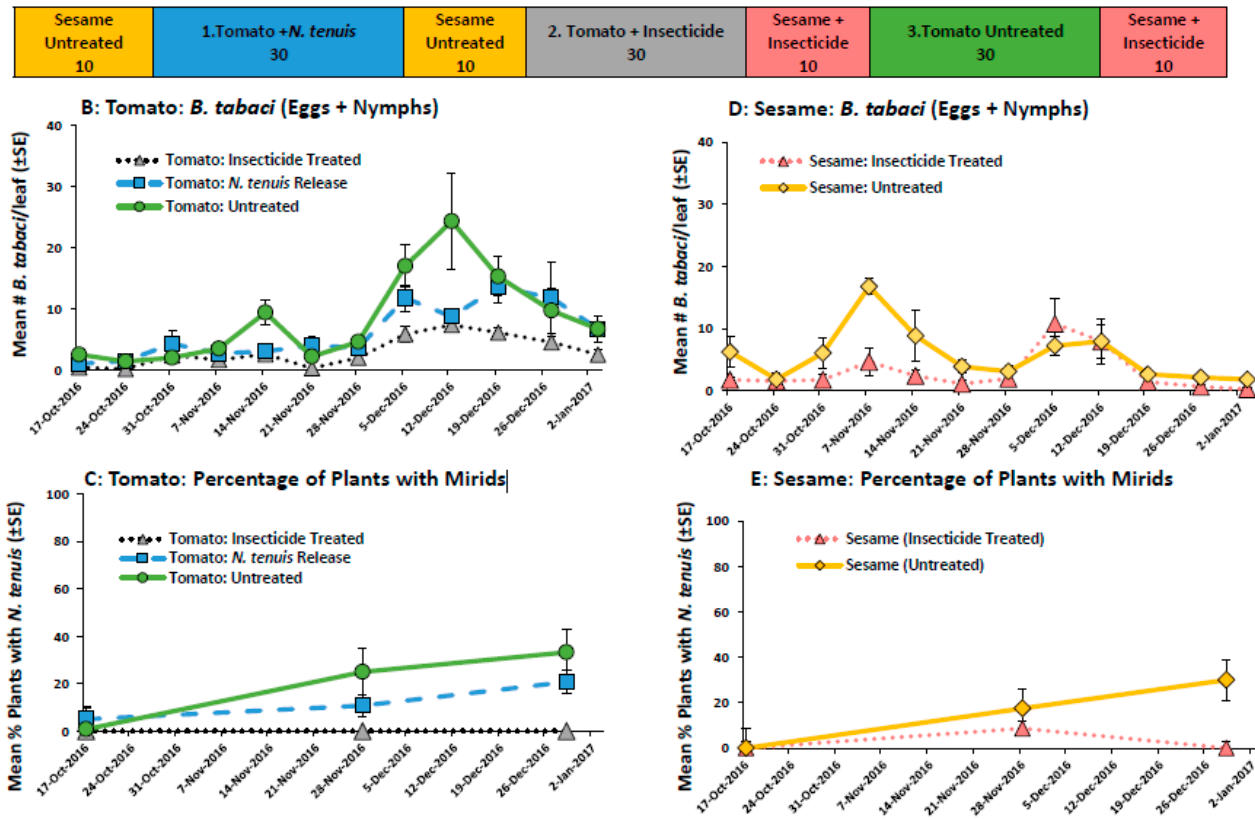
Figure 4. The field plot layout ( A ), the mean ( ± SE) number of B. tabaci (eggs + nymphs) per tomato ( B ) and sesame leaflet ( C ) and the mean ( ± SE) percentage of tomato ( D ) and sesame ( E ) plants with N. tenuis (adults + nymphs), in a study that compared insecticide-treated and N. tenuis releases to control B. tabaci . The number under each field plot treatment ( A ) indicates the number of tomato and sesame